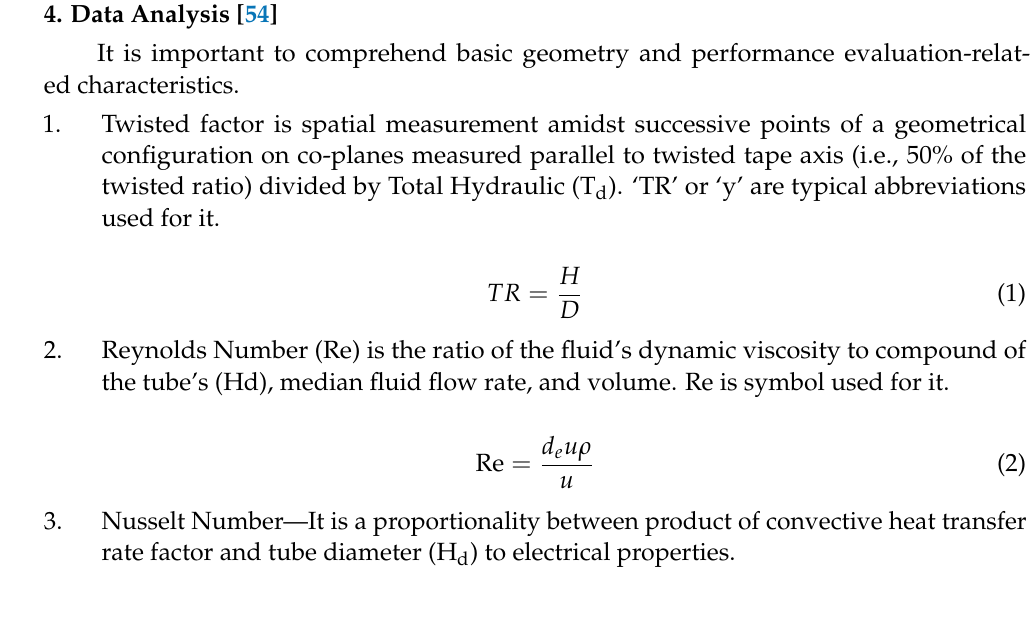
Figure 2. Twisted tape with dimple